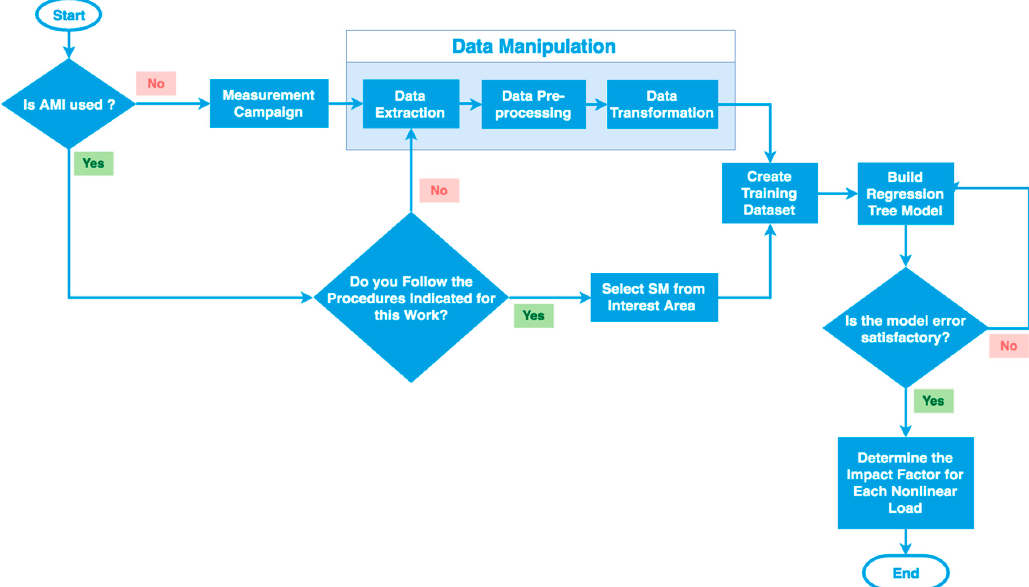
Figure 2. Overview of the proposed methodology.